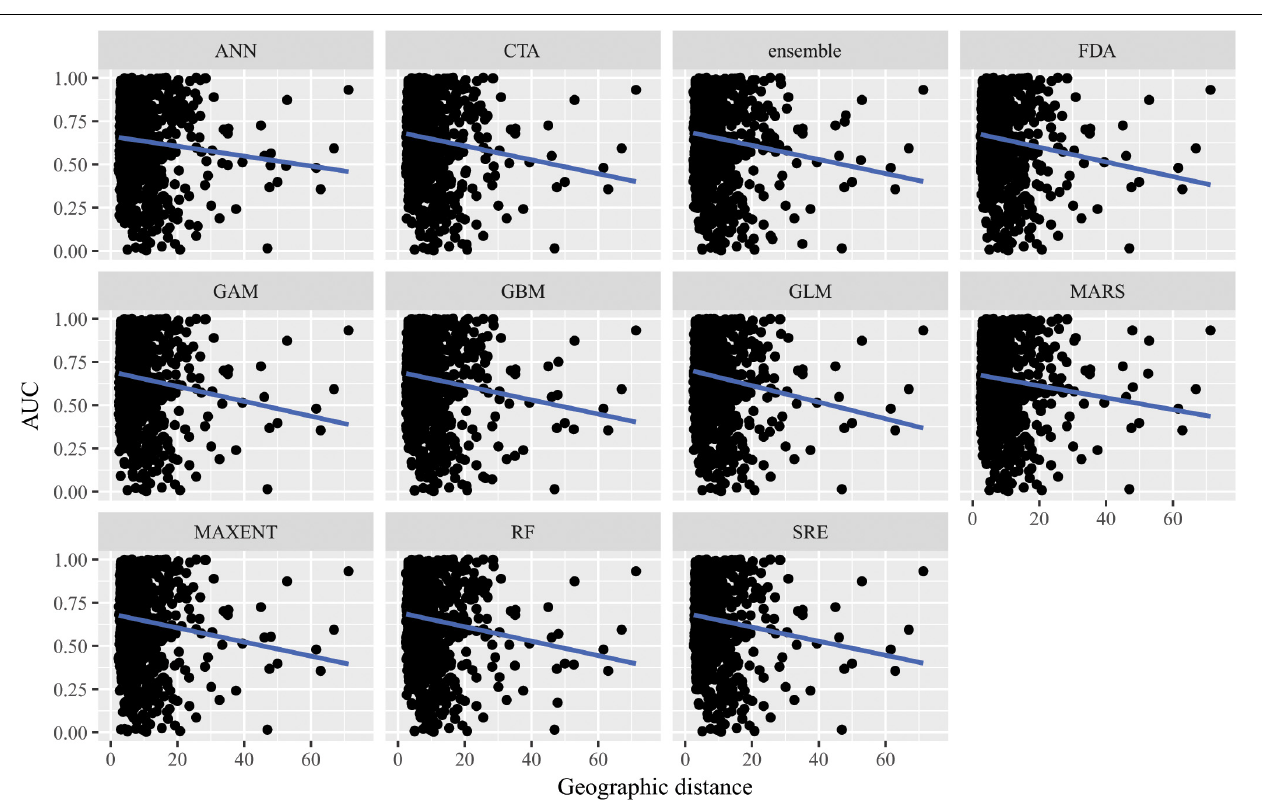
FIGURE 6 | Predictive performance of species distribution models with different algorithms as measured with AUC versus distance of extrapolation in geographic space in a novel geographic region. Distance was measured by first normalizing the distance along each variable axis, then calculating Euclidean distance, and finally dividing by the square root of the number of dimensions (i.e., 2) to obtain a normalized distance in standard-deviation